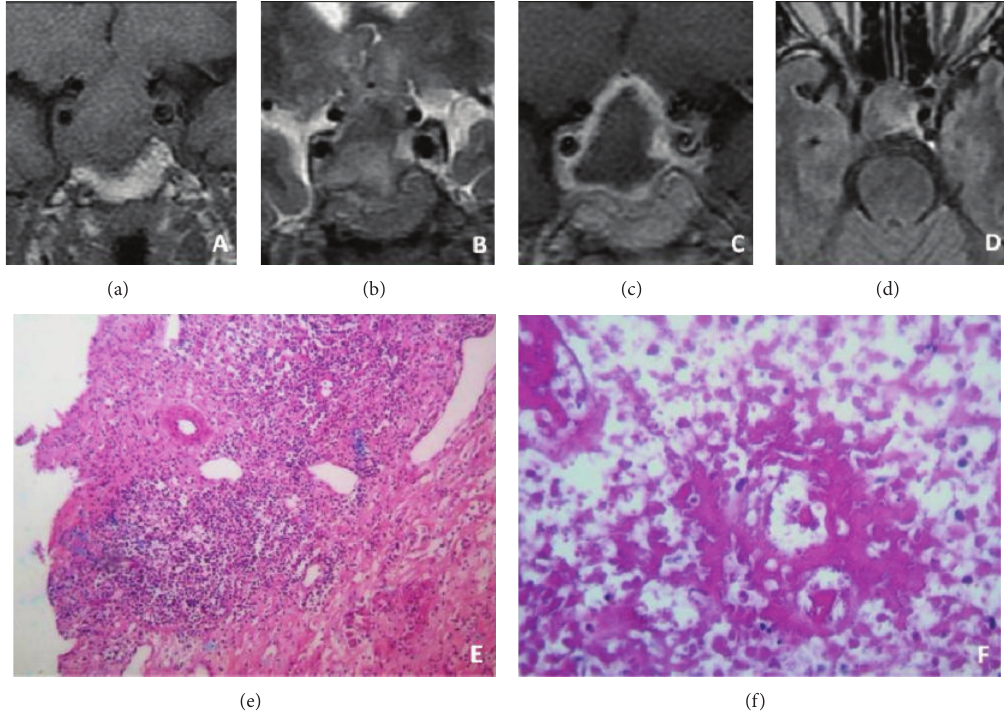
Figure 3: (a) Coronal T1-weighted images, (b) coronal T2-weighted images, and (c) coronal T1-weighted images after contrast media administration views of initial MRI of a 59-year-old man presented with of fever, nausea, vomiting, polyuria, and loss visual acuity. Intra- and suprasellar lesion contacting bilaterally the gyrus rectus and the chiasm. (e) Photomicrograph × 100 H & E and (f) photomicrograph × 100 H & E showed extensive fibrosis with lymphocytic infiltration and areas of trapped pituitary cells, vasculitis with blood vessel necrosis, adjacent tissue, and few pituitary